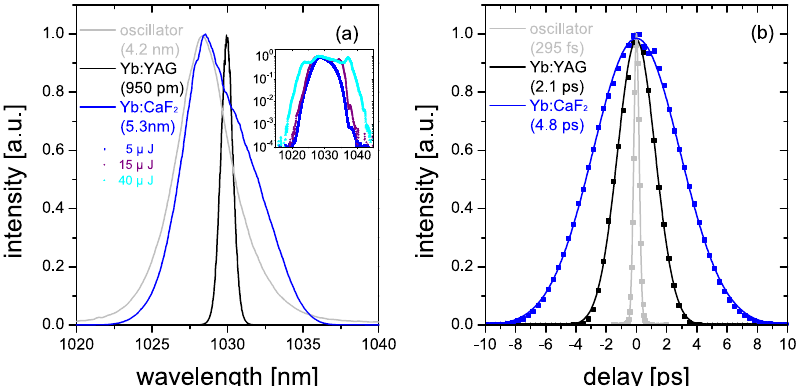
Figure 7. Output pulse spectra ( a ) and intensity autocorrelation traces ( b ) for the fs-oscillator (gray), the regenerative Yb:YAG (black) and CaF Yb:CaF at different output pulse energy in logarithmic 2